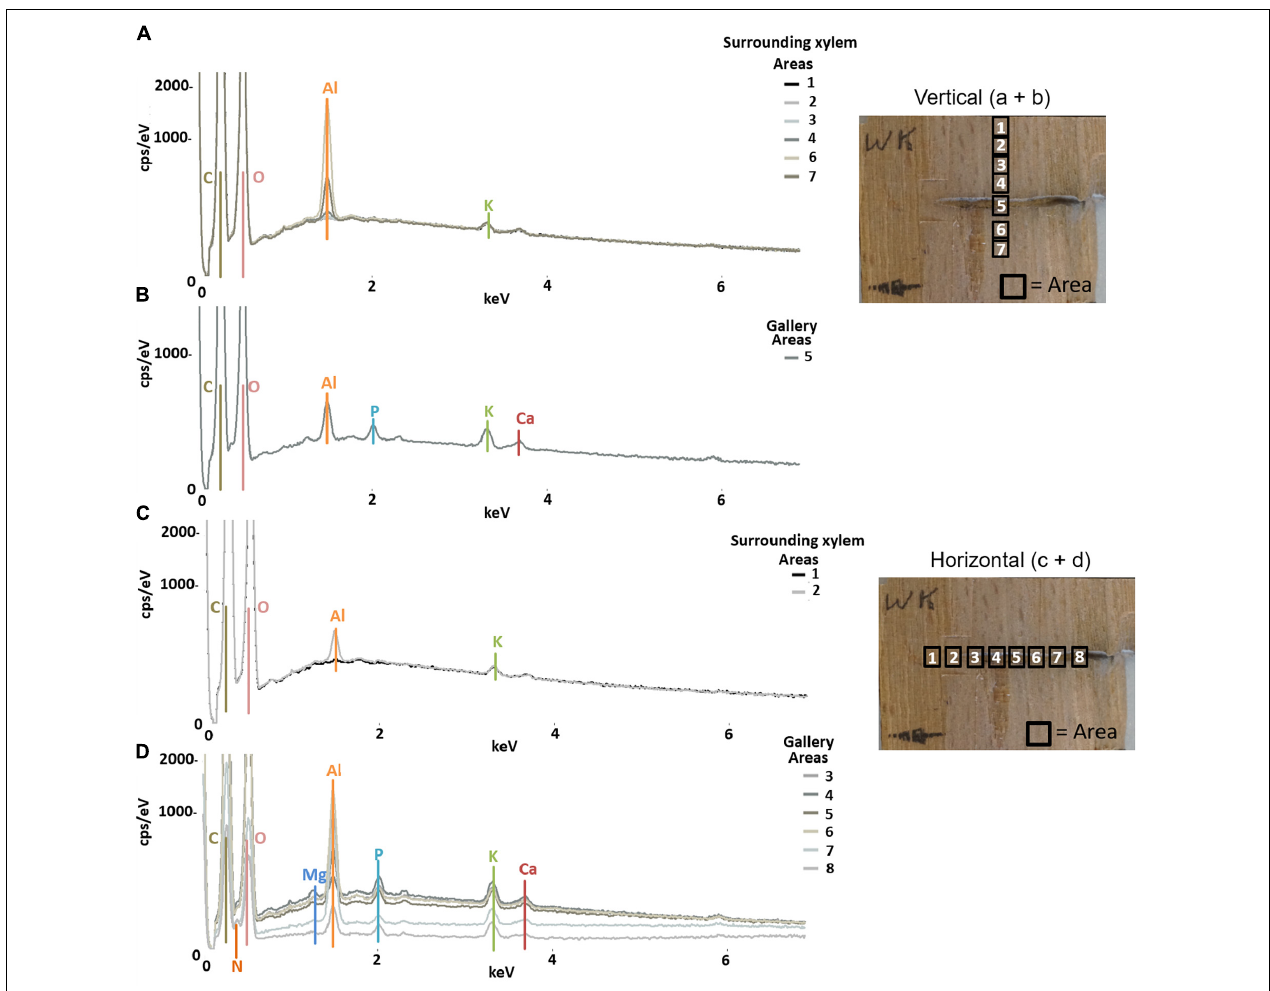
FIGURE 5 | Elemental composition of gallery walls and xylem surrounding a gallery of Elateroides dermestoides (ID = HD) using SEM-EDX. The gallery was examined in vertical (A,B) and horizontal (C,D) direction respective to wood grain; location and numbers of measured areas are given in the photos on the right. The Y -axis of each plot is counts per second (cps) per electronvolt (eV) of each element, while the X -axis is the applied electricity in kilo-electronvolt